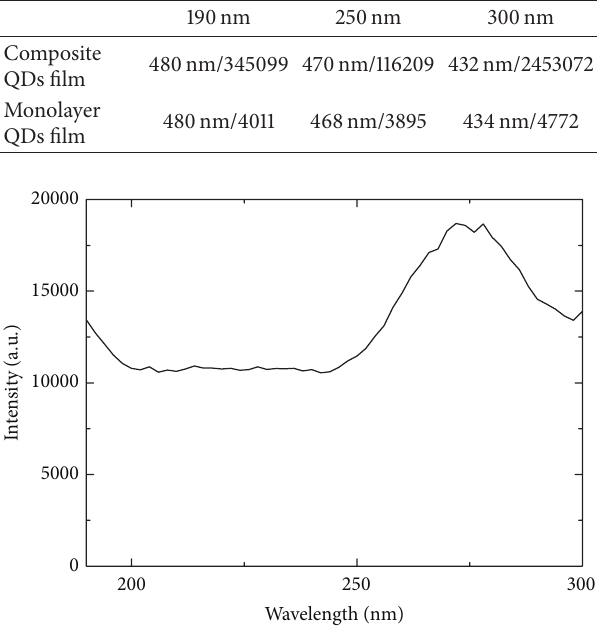
Figure 9: Photoluminescence excitation spectra of composite sam- ple emitted at 480